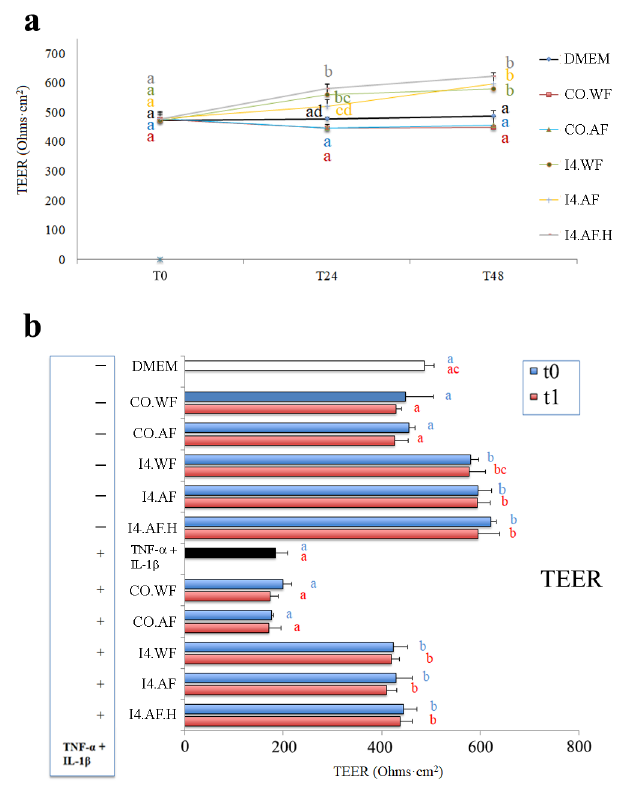
Figure 6. TEER (Ohms·cm 2 ) of Caco-2 cells. ( a ) Caco-2 cells were treated with lyophilized ice creams (100 μg/mL) and TEER was measured at time 0 (T0) and after 24 and 48 h (T24 and T48, respectively). ( b ) Caco-2 cells were treated with lyophilized ice creams (100 μg/mL), both fresh (t0) and after one month of storage at −20 °C (t1), alone or in combination with TNF- α (2 ng/mL) and IL- 1β (25 ng/mL), and TEER was measured after 24 h. CO.AF and CO.WF represent Caco-2 cells treated with no fermented ice creams, respectively, with and without the addition of dietary fibers. I4.AF and I4.WF are Caco-2 cells treated with fermented ice creams, with and without the addition of dietary fibers, respectively. I4.AF.H represents the Caco-2 cells treated with fermented ice cream with the addition of both dietary fibers and HT. DMEM alone was used as the negative control, while DMEM containing TNF- α (2 ng/mL) and IL - 1β (25 ng/mL) was used as a positive control. Data are the means (±SD) of three biological replicates analyzed in triplicate. One-way ANOVA and individual post hoc comparisons with the Tukey–Kramer was performed separately for each thesis (panel a) and for t0 and t1 (panel b). Each analysis displays superscript letters with a different color. For every analysis, measurements with different superscript letters differ significantly ( p < 0.05).